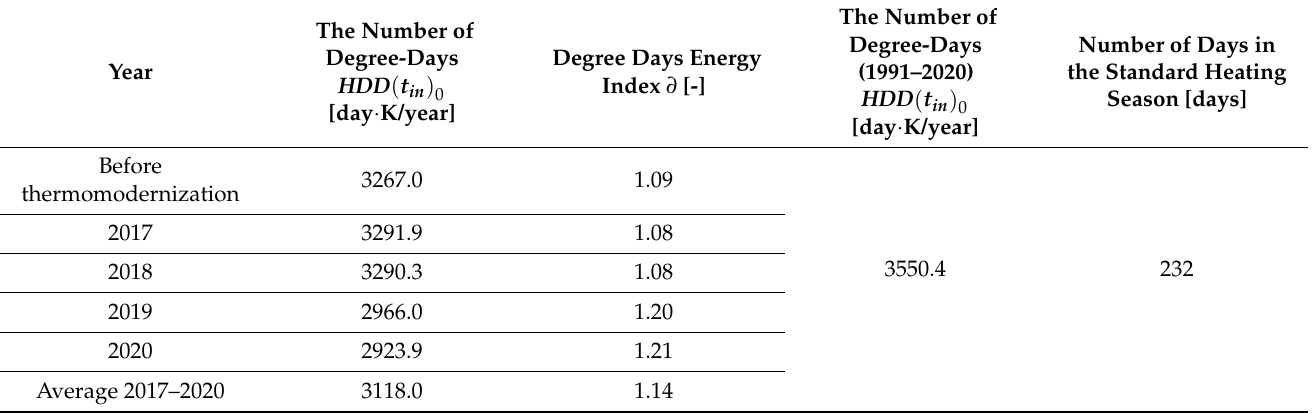
Table 5. Characteristics of “ j ”-th heating season based on the number of degree days and the energy index of degree days ∂ before and after